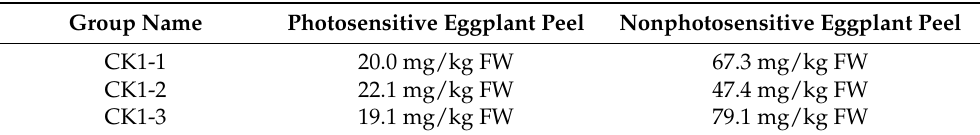
Table 1. Anthocyanin content of photosensitive and nonphotosensitive eggplant in control group. Group